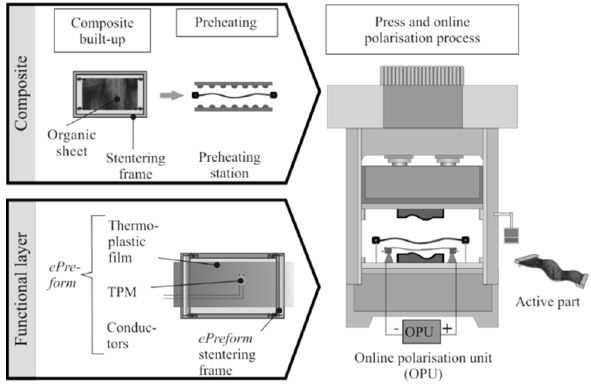
Figure 10. Schematic manufacturing process of active TRTC.